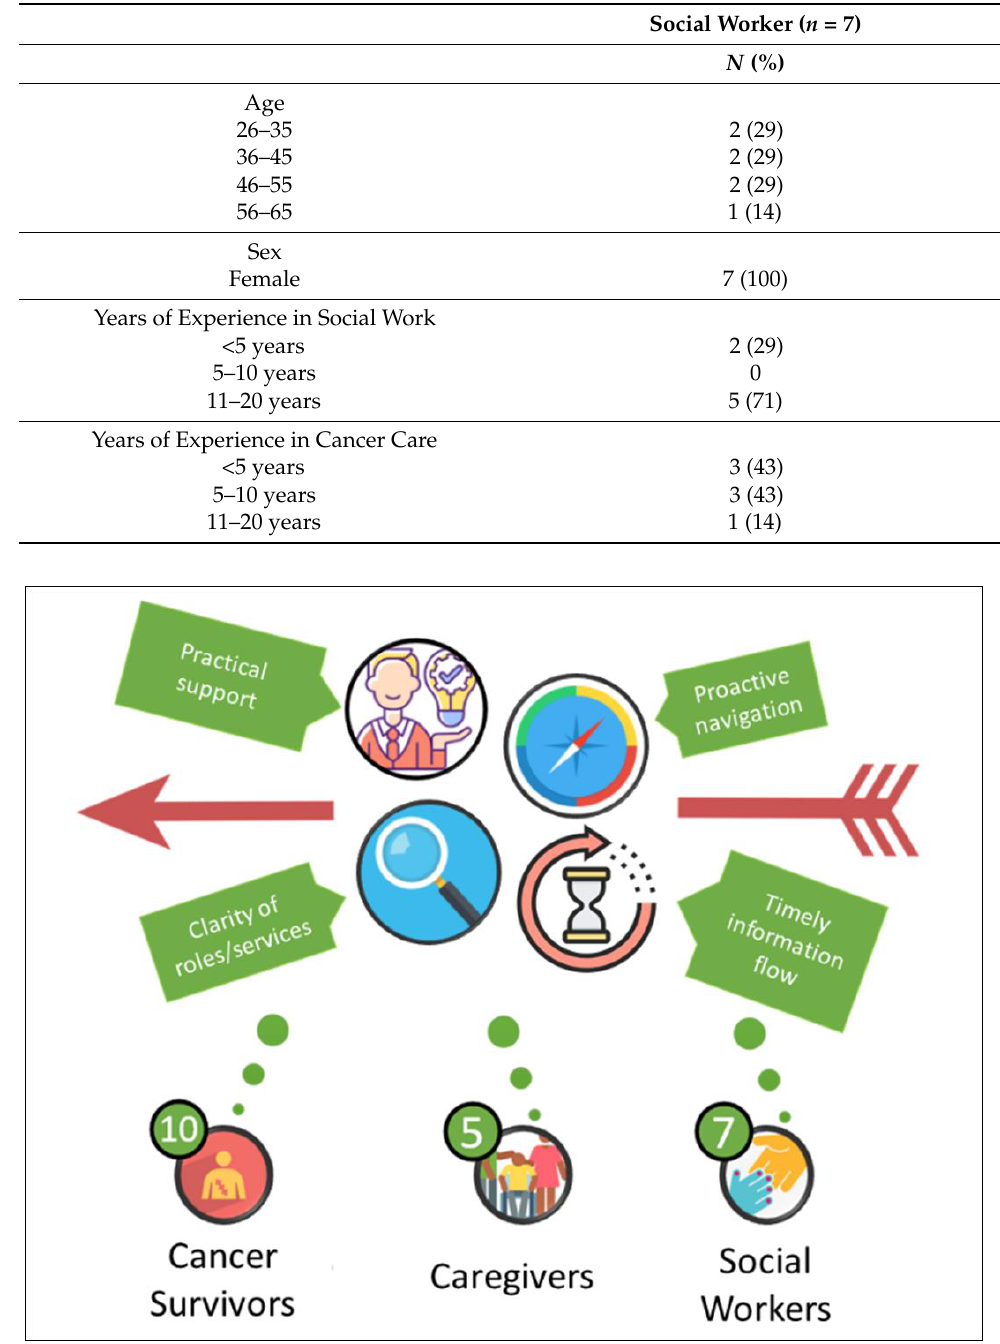
Table 2. Characteristics of the Social Workers.